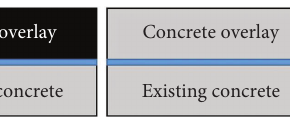
Figure 1: Bonded